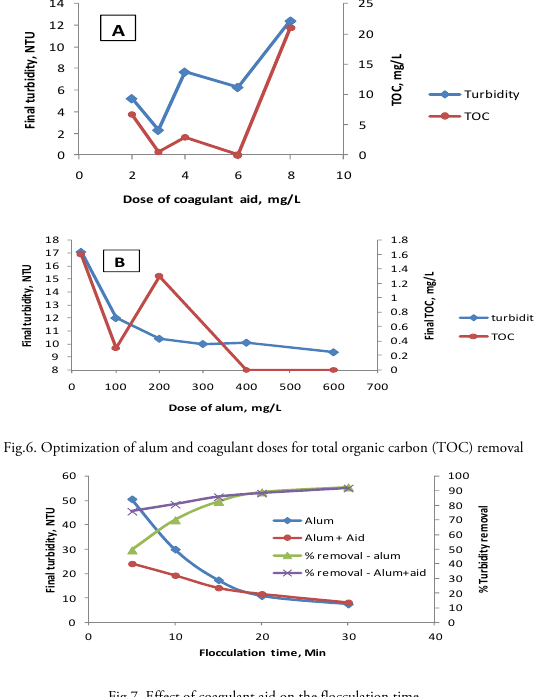
Fig.7. Effect of coagulant aid on the flocculation time